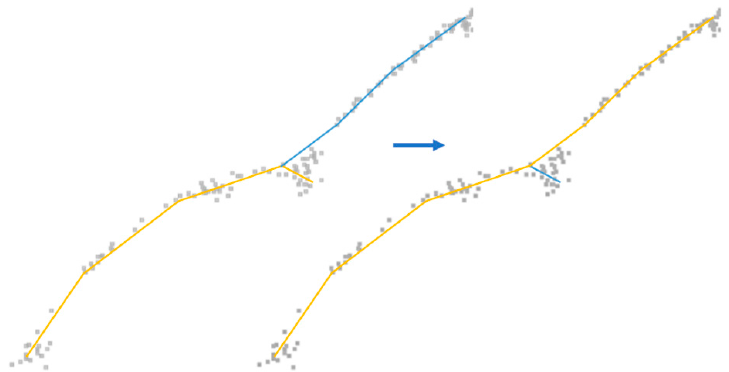
Figure 5. Example of branch connection refinement. Gray dots are scanned branch points, yellow and blue lines are connection lines. The right panel shows a more natural way of connection than the left.